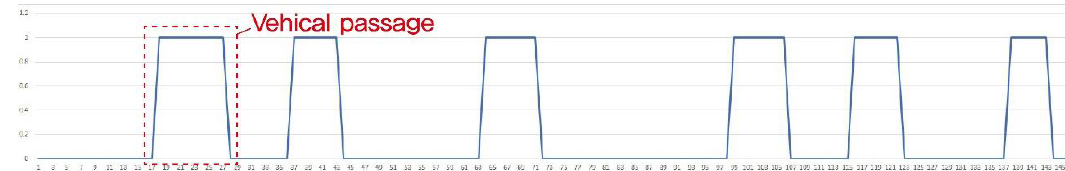
Figure 7. Final signal profile of vehicle passages when using synthesized images for the test data.